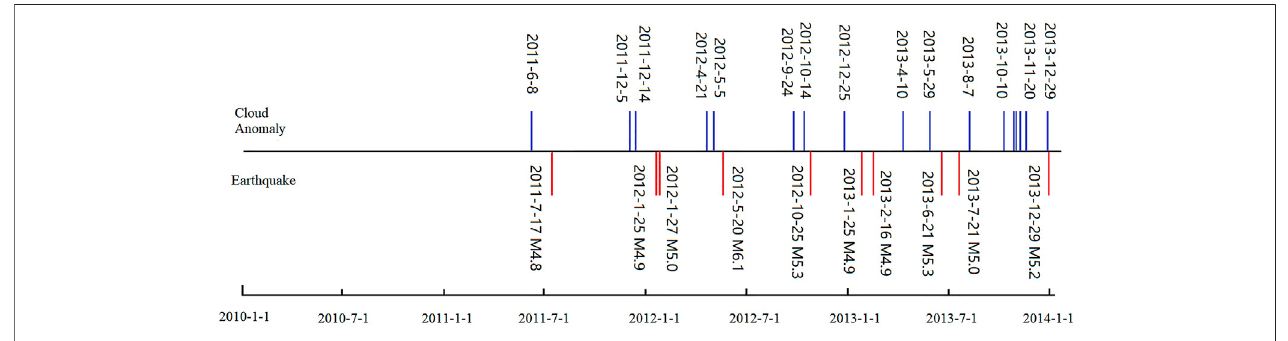
FIGURE 3 | Time series of cloud anomalies and earthquake occurrences in Italy during 2010 – 2013.